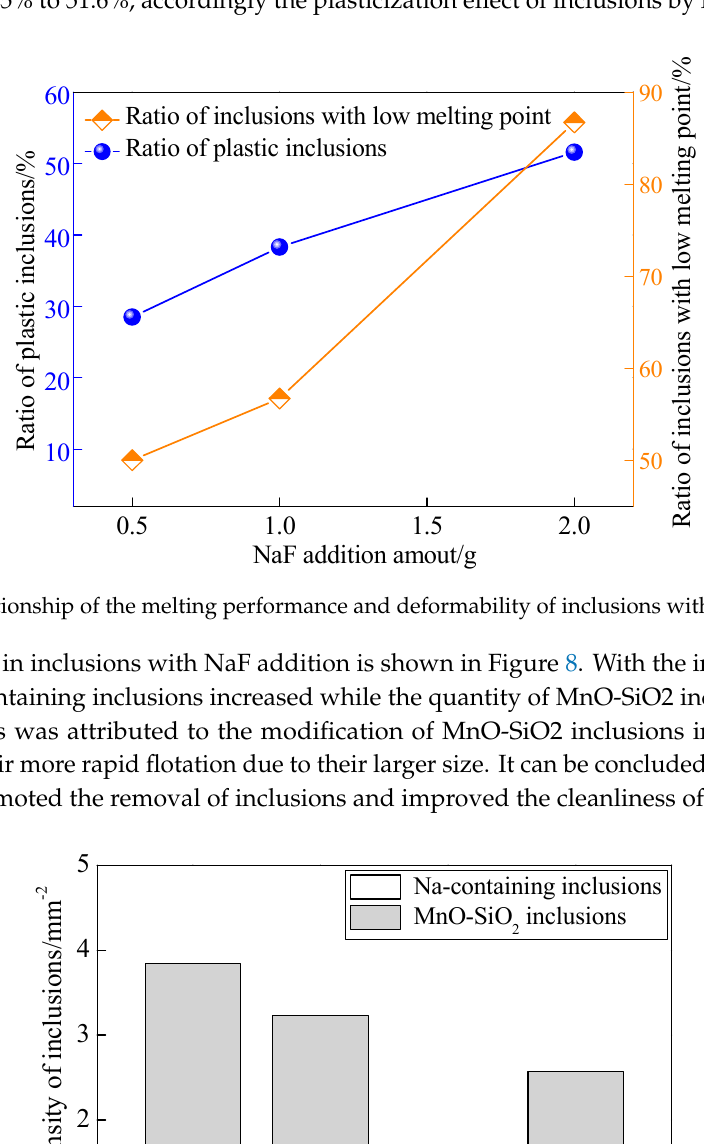
Figure 6. Distribution of inclusions in wire rods from Heats A, B and C. Solid symbols represent the average composition in each heat.